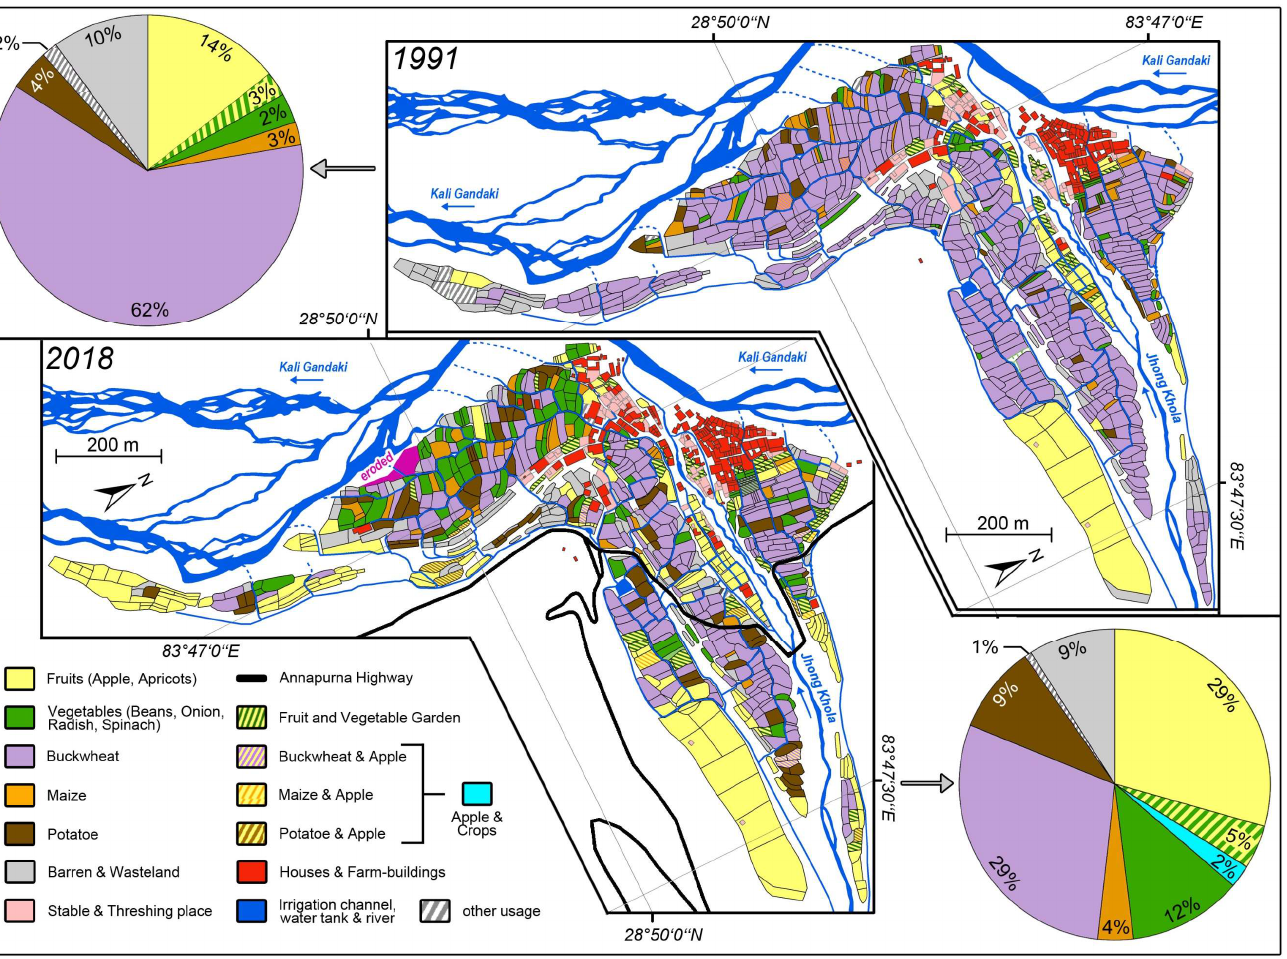
Figure 8. Land use at Kagbeni settlement during the autumn season in 1991 and 2018. Pie charts represent the relative area of the various crops in relation to the total arable land. The intercropping of apples with buckwheat, maize, and potatoes are grouped as cyan within the pie chart. The underlying detailed on-site mappings were performed in Oct. 1991 and Oct. 2018, respectively. Projection WGS 1984 UTM Zone 44N (scale 1:12,500).